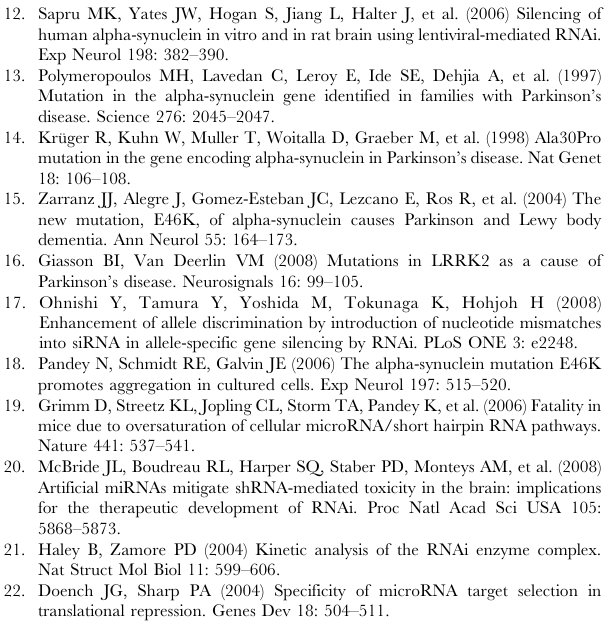
Table S1 Oligonucleotide sequences